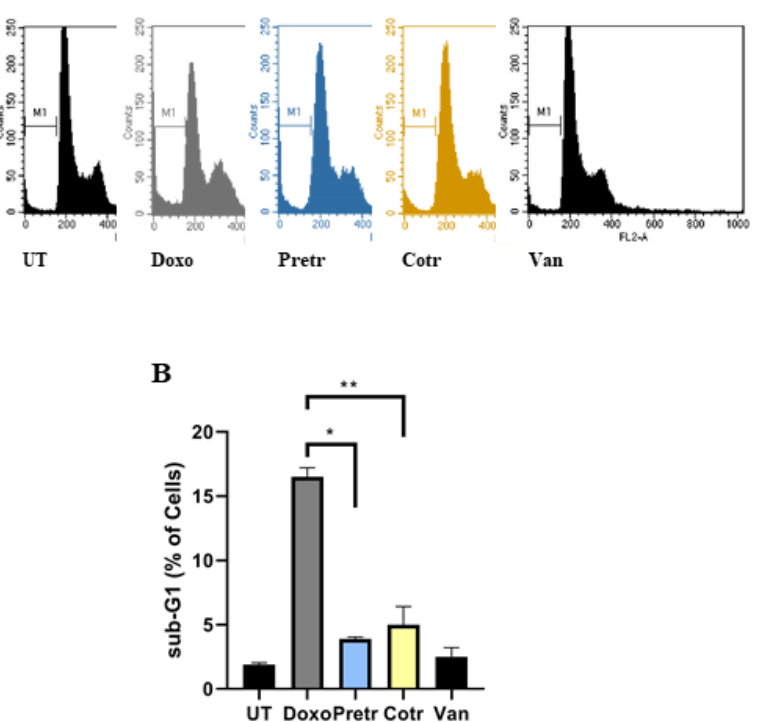
Figure 4. Effect of vanillin on doxo-induced sub G1-phase alteration. ( A ) Representative experiments of PI-stained H9c2 cells exposed to 20-μM doxo for 24 h, pretreated (Pretr) and co-treated (Cotr) with 100-μM vanillin. UT— untreated cells; doxo— cells exposed to 20-μM doxo; Van— cells exposed to 100-μM Van; ( B ) sub-G1 phase quantification of not less than two. Data represent the average of three independent experiments ± SD. *: p < 0.05; **: p < 0.01 by one-way ANOVA. Other experimental details are described in Materials and Methods